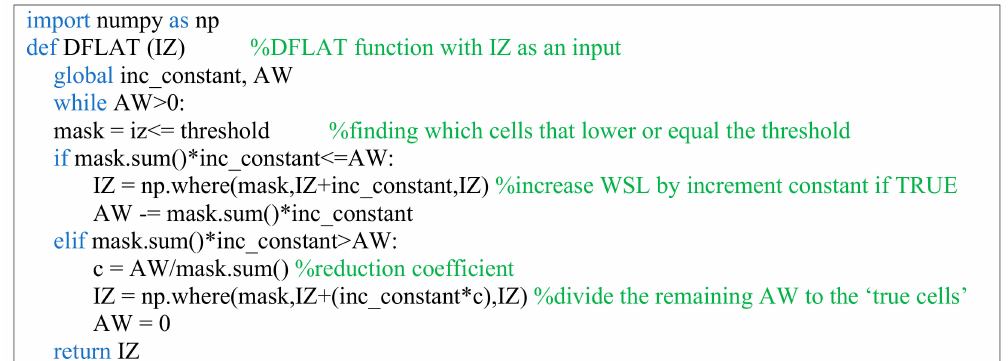
Figure 4. Pseudocode for distributing the water volume within the coarse grid cells to the finer grid cells. The IZ parameter refers to the ground elevation within the